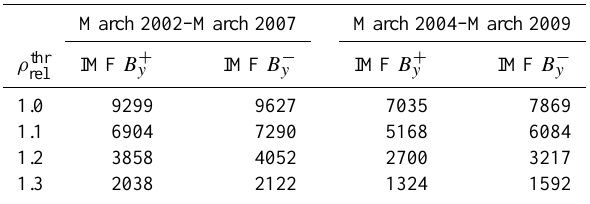
Table 2. The sample number distribution of prominent density en- hancements, ρ pr , for all seasons together. The results are listed sep- rel arately for solar maximum and minimum conditions for IMF B y sign and for the different levels of ρ thr . rel